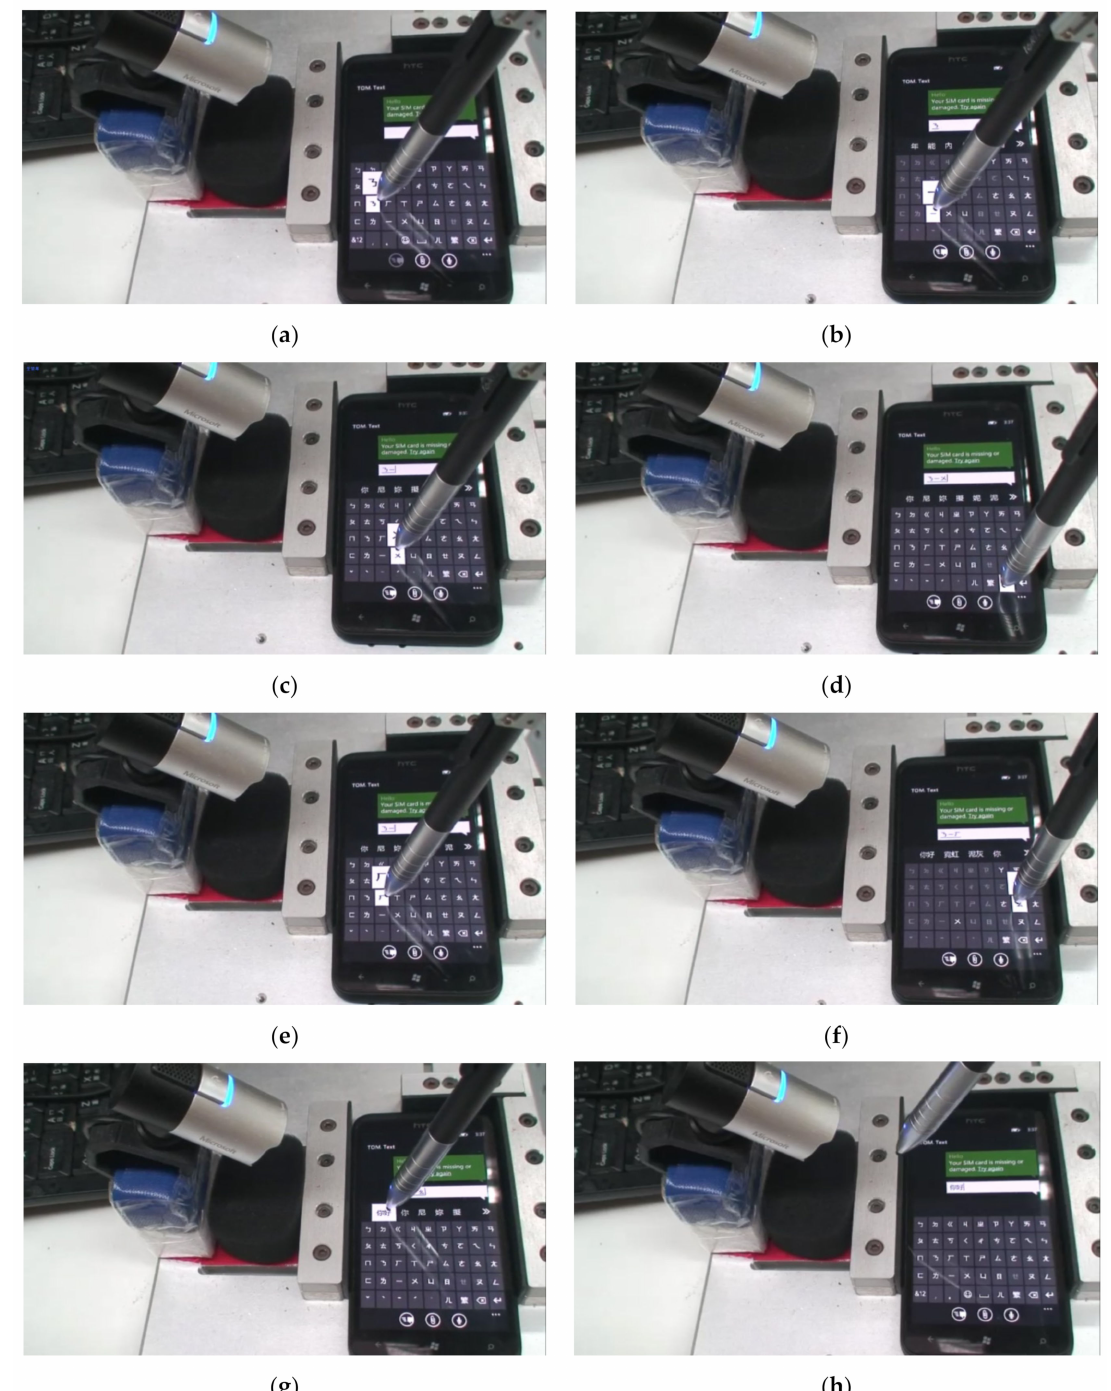
Figure 29. Delete wrong symbols. ( a ) Press symbol “ ㄋ ”. ( b ) Press symbol “ ㄧ ”. ( c ) Press wrong symbol “ ㄨ ”. ( d ) Delete wrong symbol “ ㄨ ”. ( e ) Press symbol “ ㄏ ”. ( f ) Press symbol “ ㄠ ”. ( g ) Press characters “ 你 好 ”. ( h ) Confirm characters “ 你 好